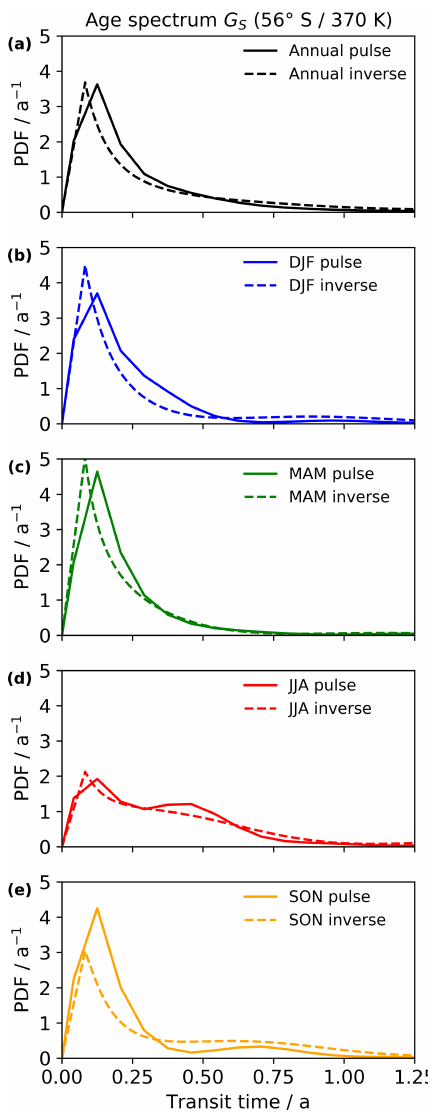
Figure 4. Normalized age spectra with reference at the southern hemispheric tropopause region G S at 56 ◦ S and 370K as annual (a) and seasonal (b–e) means. The solid line denotes age spectra from CLaMS pulse tracers, and the dashed line denotes inverse method age